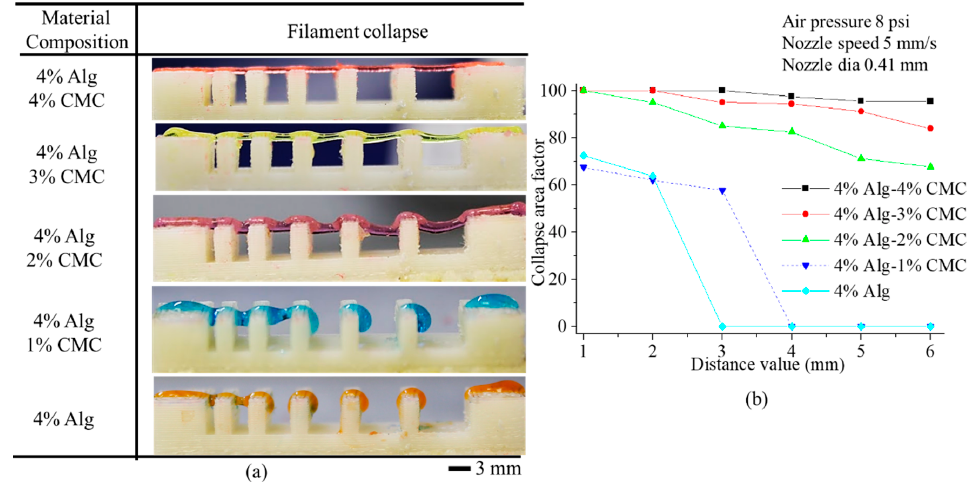
Figure 12. ( a ) Filament collapse test and ( b ) Collapse area factor.